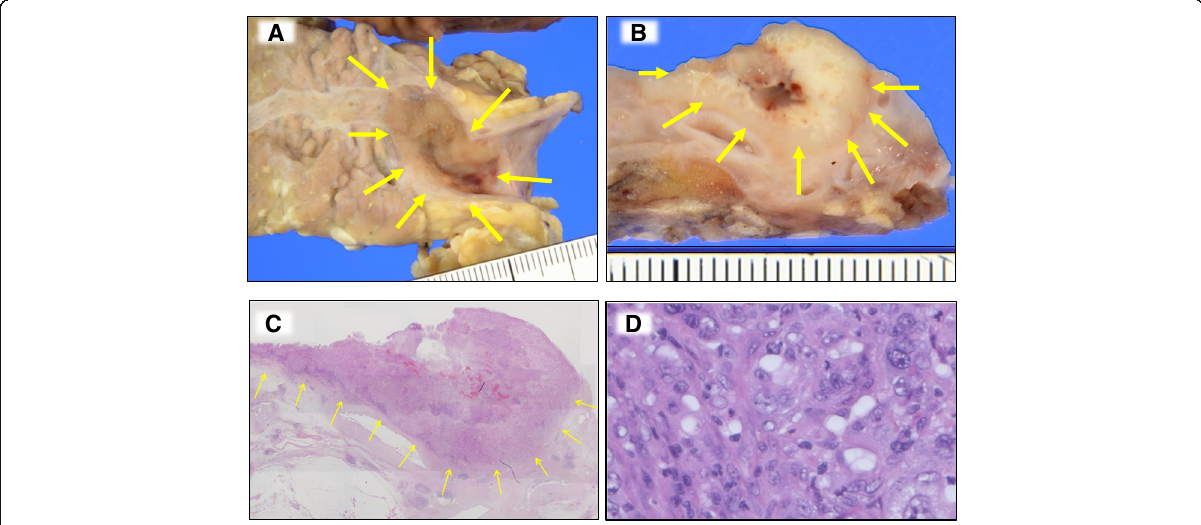
Fig. 2 Pathologic findings. a – c The resected tumor (indicated by arrows). A solid mass developed in the pancreatic duct ( a ). Cut surface of the pancreatic duct demonstrates a well-demarcated whitish mass ( b ). The tumor has a pushing border in the loupe image ( c ). d Medullary growth with prominent lymphocytic infiltration is observed. The tumor contains some syncytial